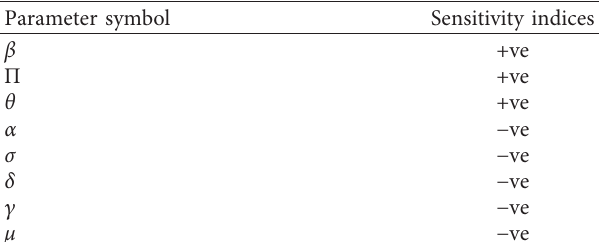
Table 6: Sensitivity index